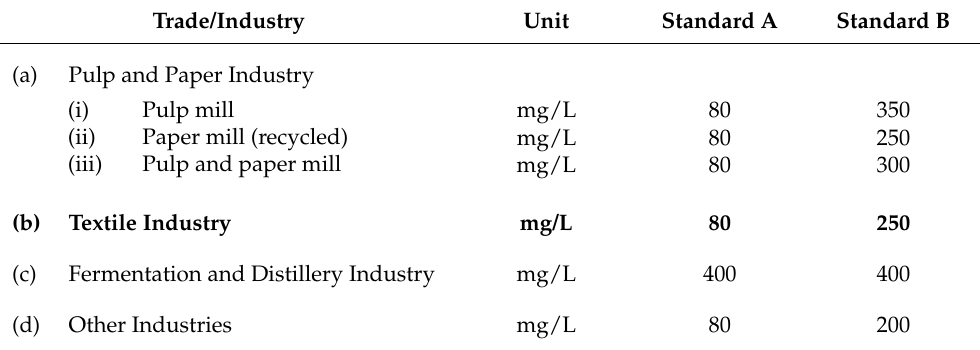
Table 5. Acceptable chemical oxygen demand (COD) for the discharge of industrial effluents for specific trade or industry sector regulated by the Malaysian Ministry of Natural Resources and the Environment